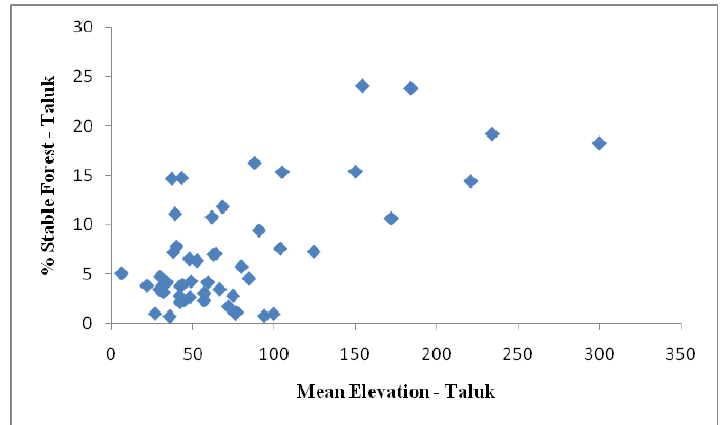
Figure 8b. Relationship between mean elevation and the distribution of stable forest for taluks.